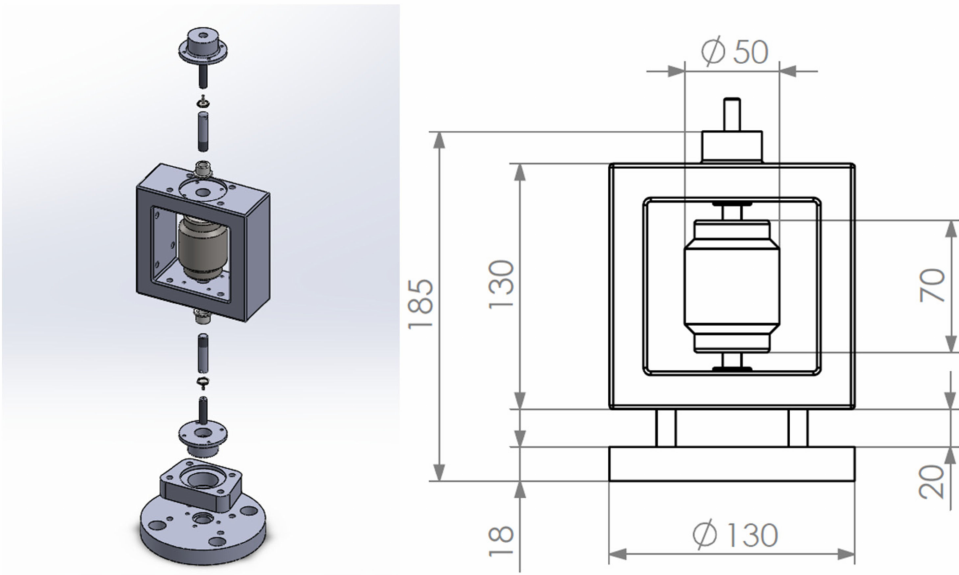
Figure 5. Layout and dimensions of the HW in the z axis configuration